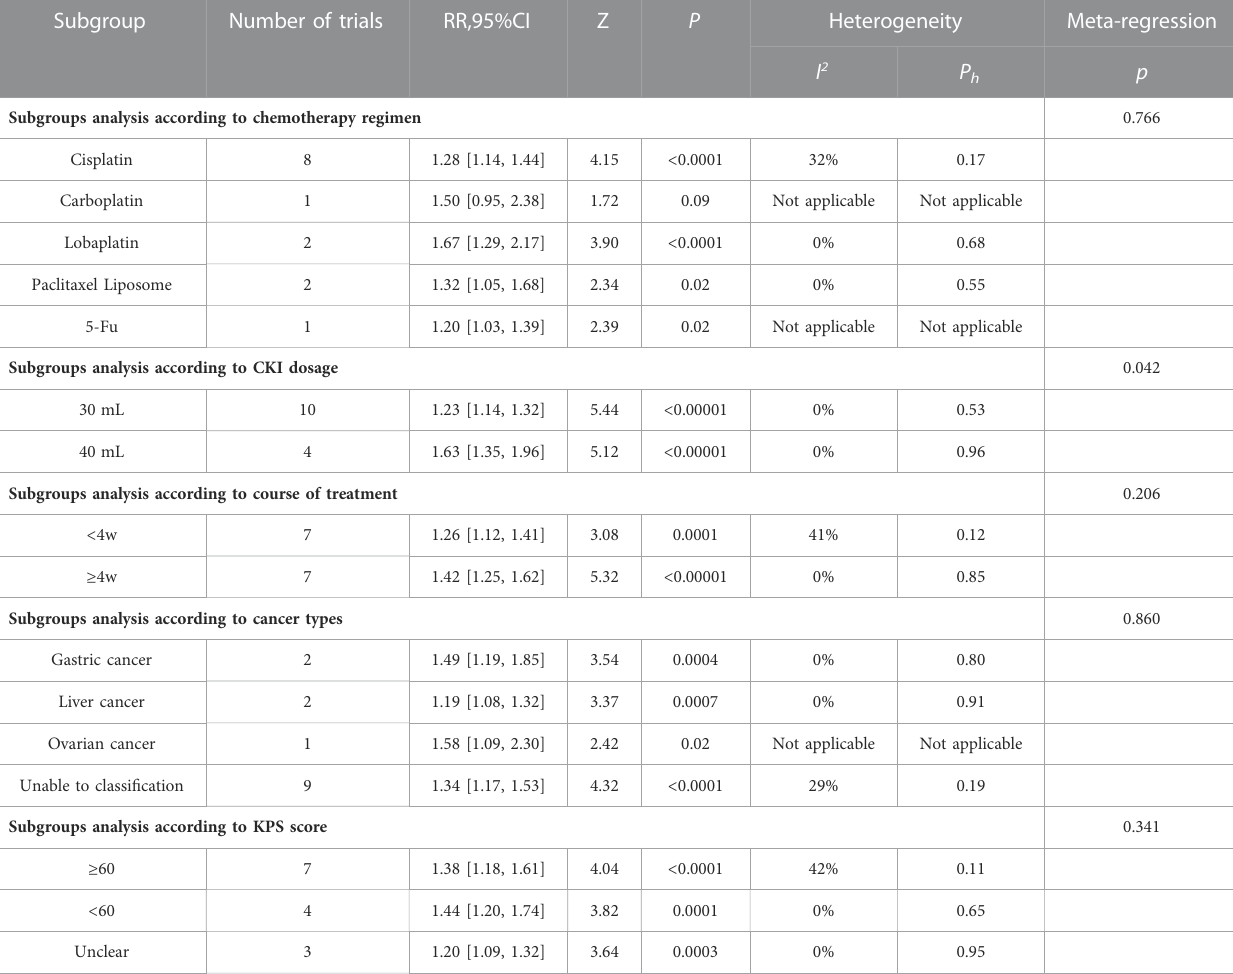
TABLE 2 Subgroup analysis of the ORR.